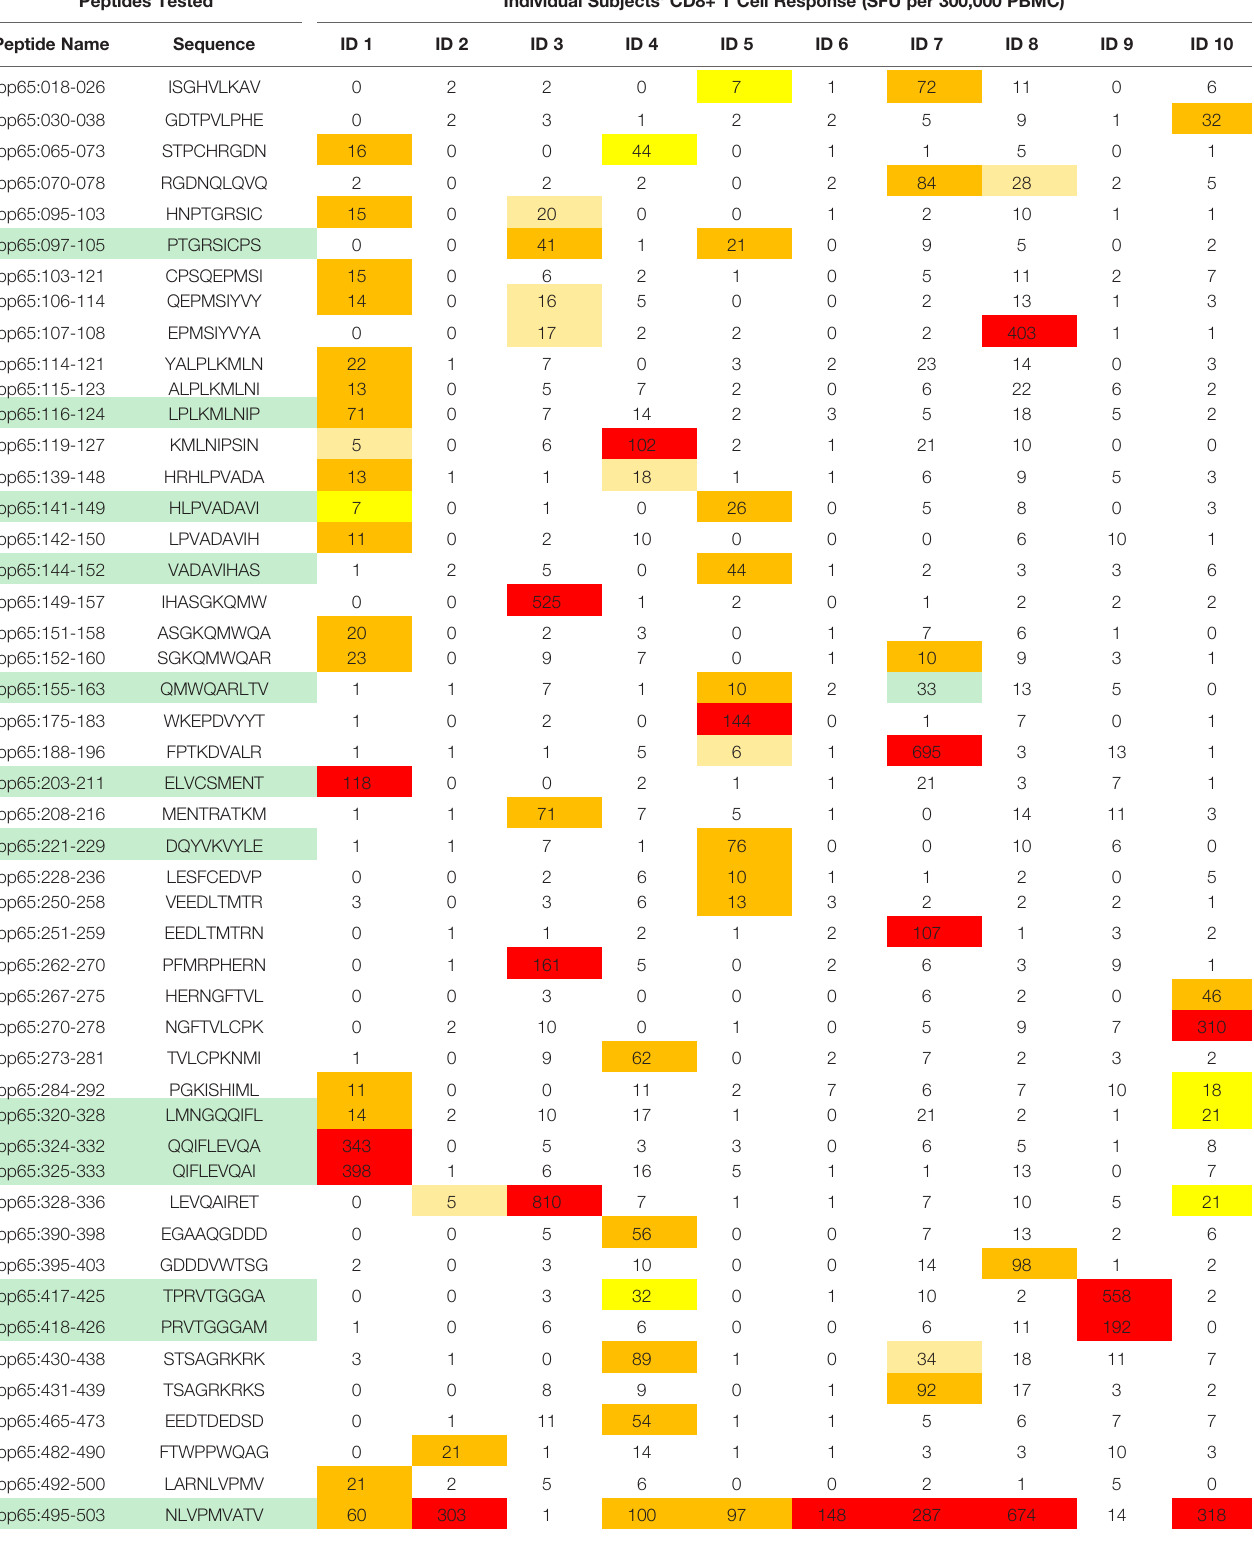
TABLE 1 | HCMV ppp65 epitope recognition by CD8+ T cells in HCMV positive, HLA-A*02:01 positive subjects. Peptides